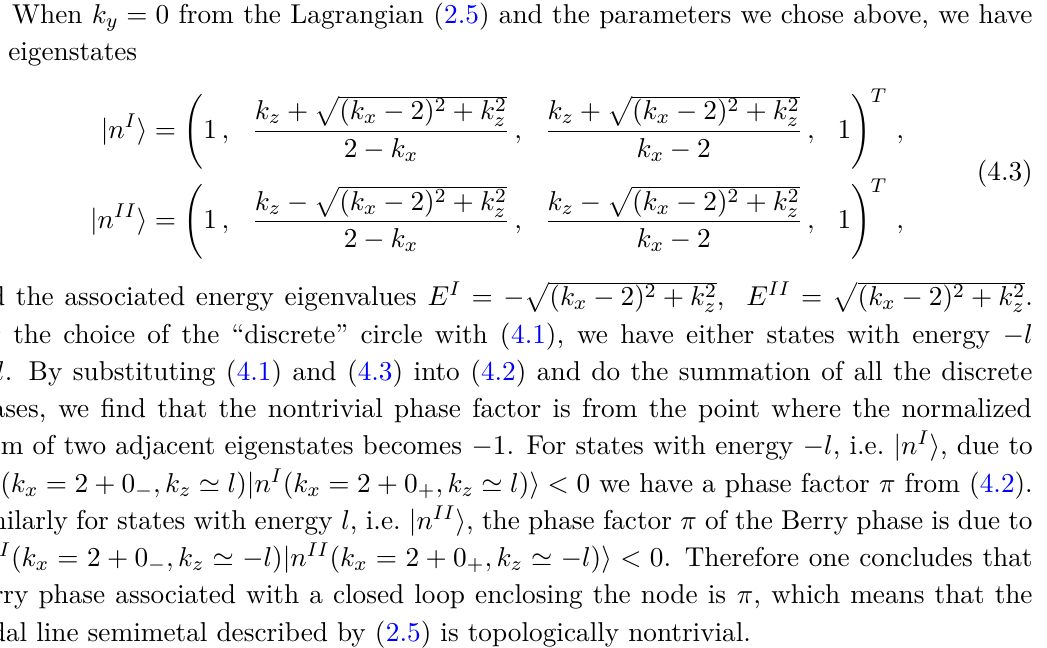
where | n i and | n i are eigenstates at two adjacent discrete points i i 1 i 2